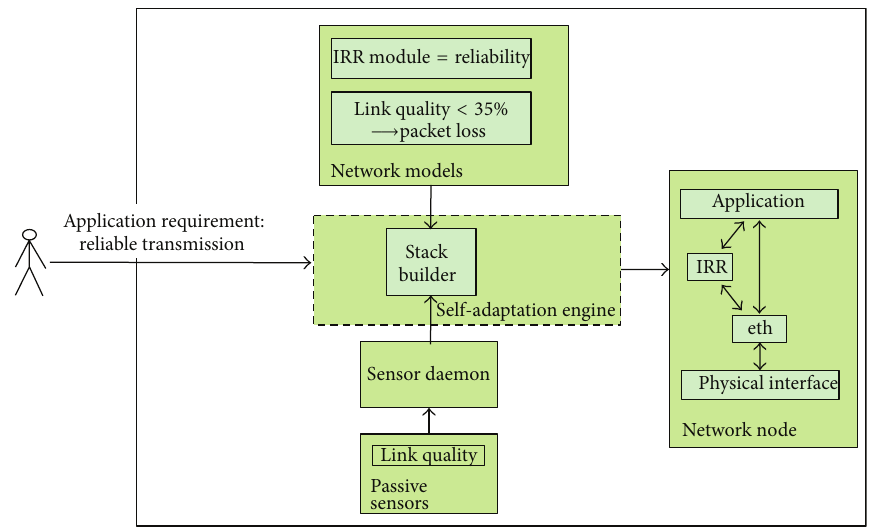
Figure 7: Implementation of the node architecture for the link-quality-aware protocol stack [6].